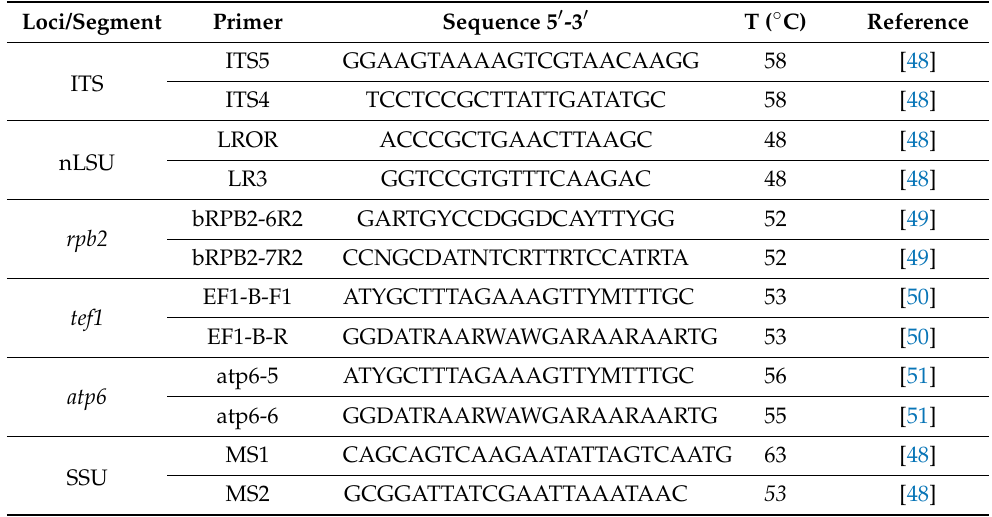
Table 1. Primers used in the amplification and sequencing of the DNA fragments.